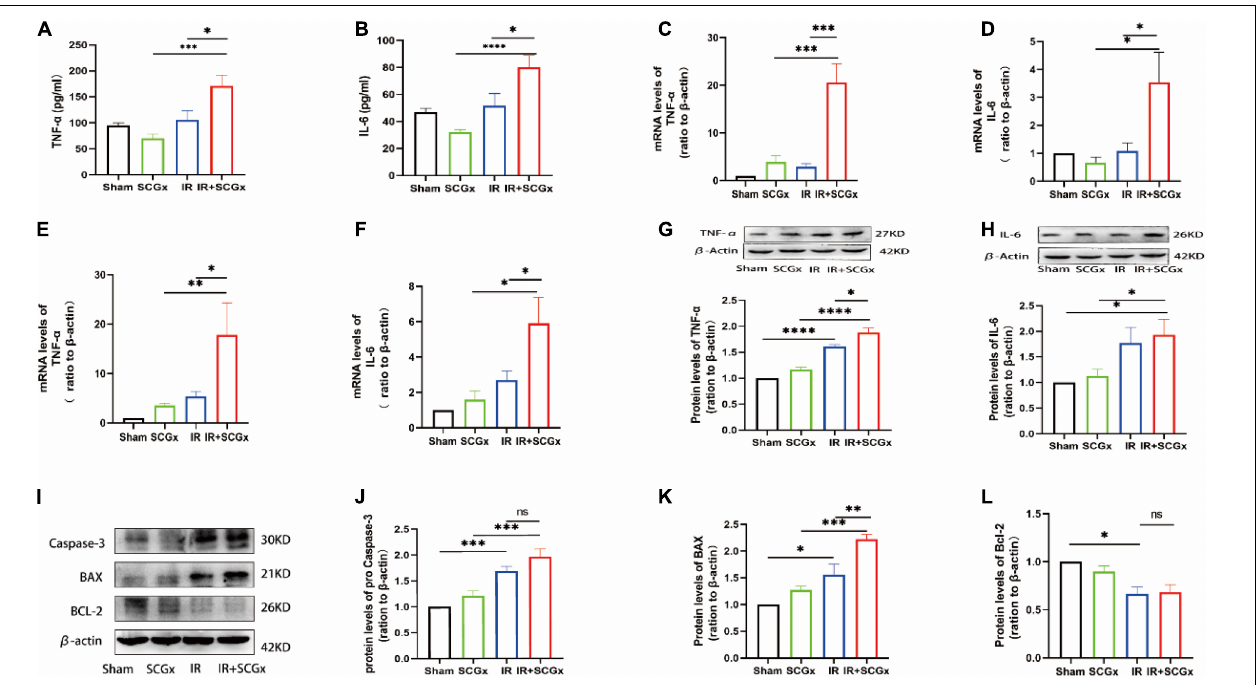
FIGURE 3 | Enhanced inflammation response and expression of pro-apoptosis protein upon sympathetic denervation. (A,B) The TNF- α and IL-6 are concentrated in plasma by ELISA. (C,D) Real-Time PCR for TNF- α and IL-6 in the hypothalamus. β -actin used as internal control. (E,F) Real-Time PCR for TNF- α and IL-6 in the kidney. β -actin used as internal control. (G,H) The protein levels of TNF- α and IL-6 in the kidney. β -actin served as an internal control. (I) Representative images of protein levels of Bax, Bcl-2 and pro Caspase-3. (J–L) Expression levels of Bax, Bcl-2 and Caspase-3 in the kidney were normalized to β -actin levels within the same